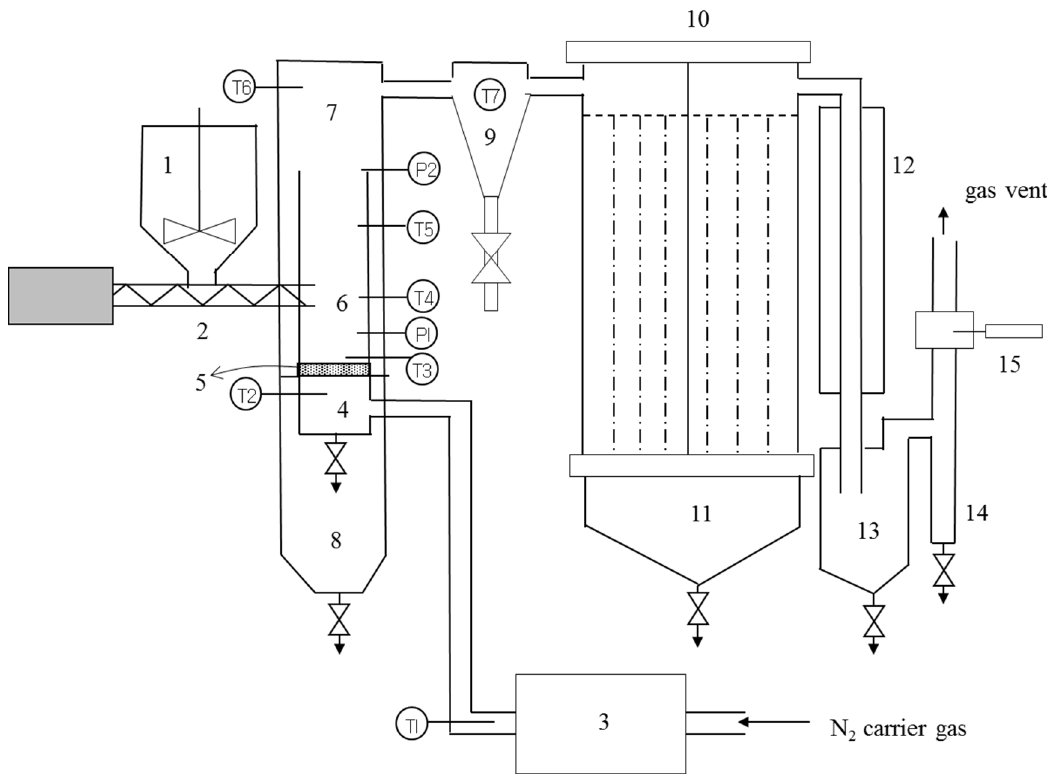
Figure 1. Schematic diagram of the biomass fast pyrolysis system. ( 1 ) Hopper; ( 2 ) Screw feeder; ( 3 ) Carrier gas preheater; ( 4 ) Gas chamber; ( 5 ) Distributor; ( 6 ) Pyrolysis reactor; ( 7 ) Free board; ( 8 ) Reactor bottom-char collector; ( 9 ) Cyclone; ( 10 ) Condenser; ( 11 ) First bio-oil collector; ( 12 ) Cooler; ( 13 ) Second bio-oil collector; ( 14 ) Third bio-oil collector; ( 15 ) Gas sample outlet.